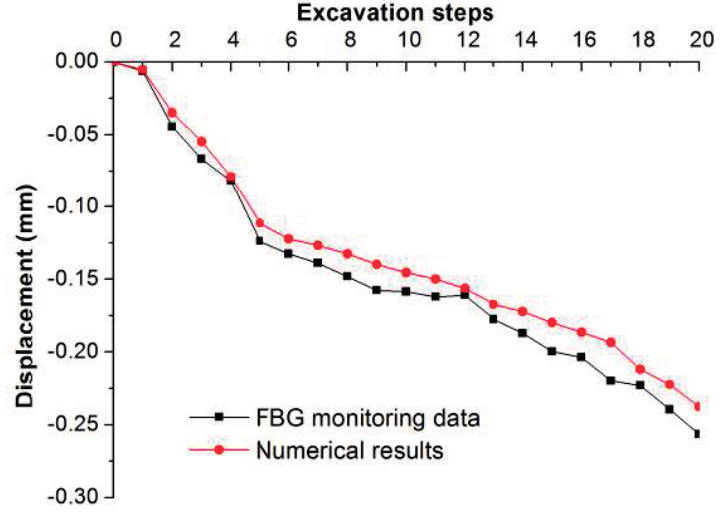
Figure 11. The horizontal displacement curves with the excavation steps obtained by FBG sensing bar and numerical simulation at monitoring point